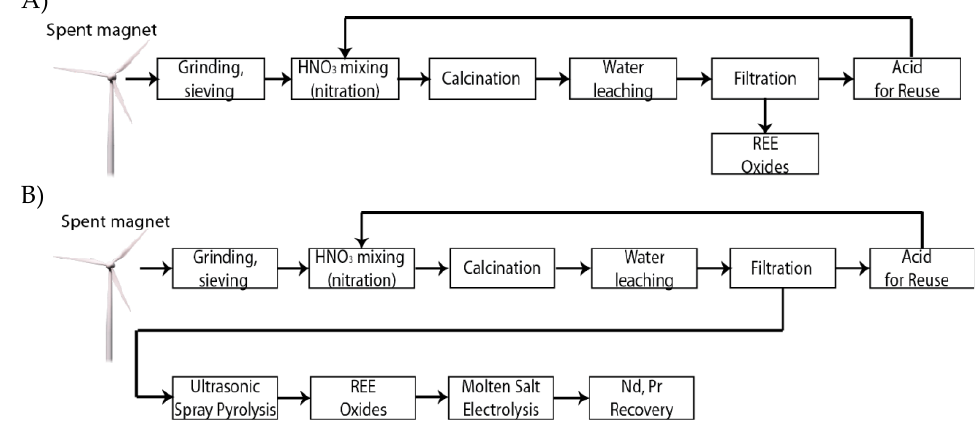
Figure 7. Recycling of NdFeB magnet from wind turbine by acid mixing, calcination, and water leaching ( A ), along with an added step of ultrasonic spray pyrolysis ( B ) flow